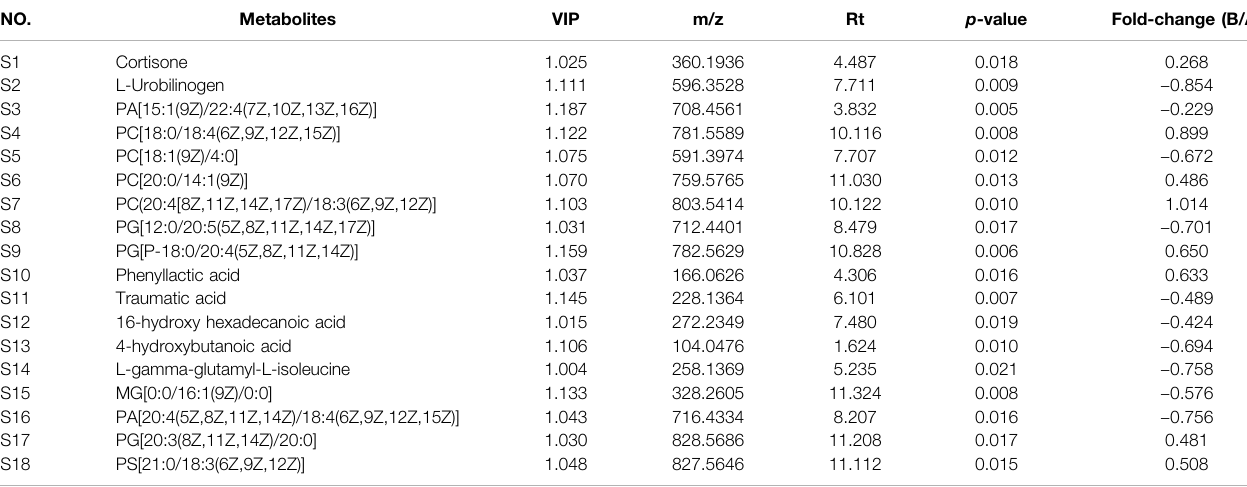
TABLE 3 | Potential metabolites characterized in the serum pro fi le and the altered trends in different groups. NO.